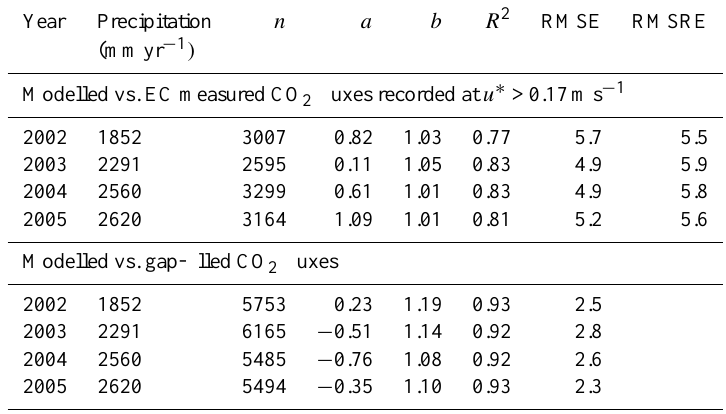
∗ (a,b) from simple linear regressions of modelled on measured. R 2 =coefficient of determination and RMSE=root-mean-square for errors from simple linear regressions of measured on modelled. All algorithms for estimation of random errors in EC measurements developed for forests by Richardson et al. (2006).